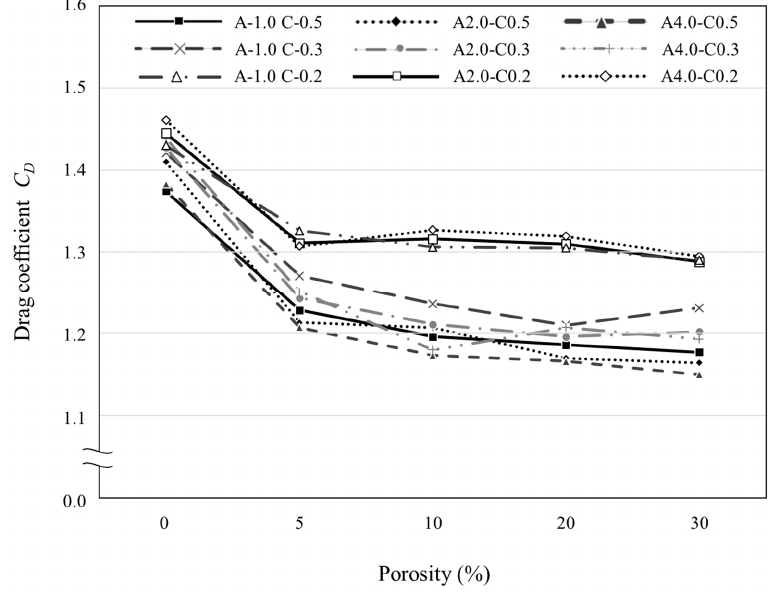
Figure 8. Correlation between porosity and drag coefficient.